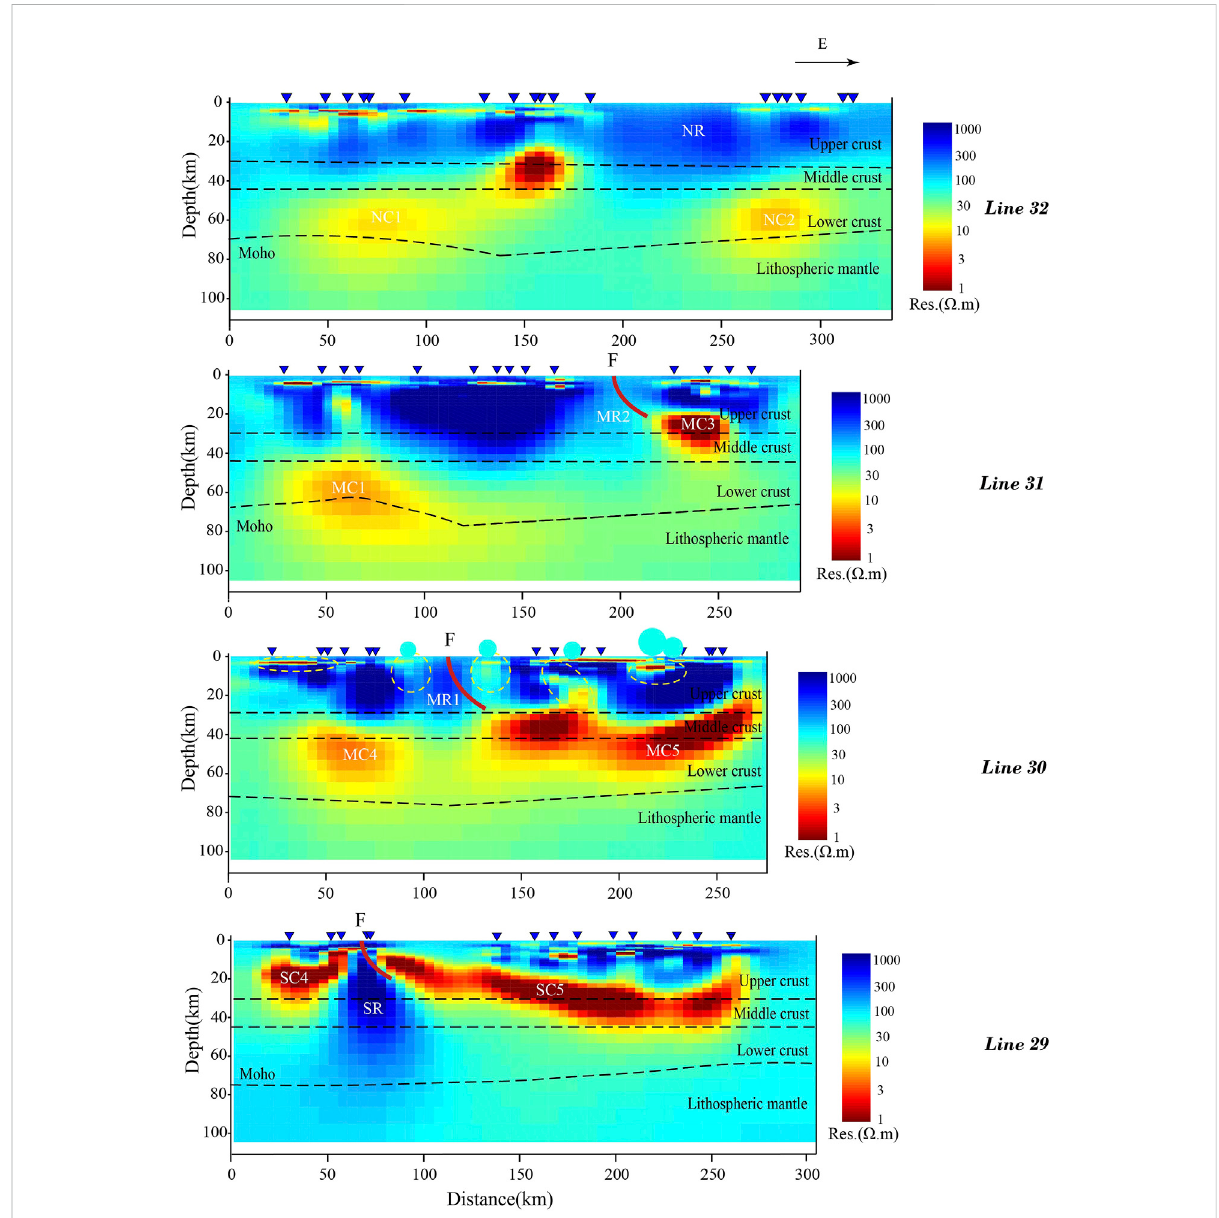
FIGURE 6 Cross sections of 3-D electrical resistivity model, approximately oriented East to West (line 29, line30, line 31, line 32 marked in Figure 5). Inverted triangles: magnetotelluric measurement stations; Red lines: Yadong-Gulu rift; Cyan circles: major Miocene porphyry Cu-Mo deposits (PCDs); Yellow dashed open circles: possible supply magma chambers. The Moho depths are from Li et al.